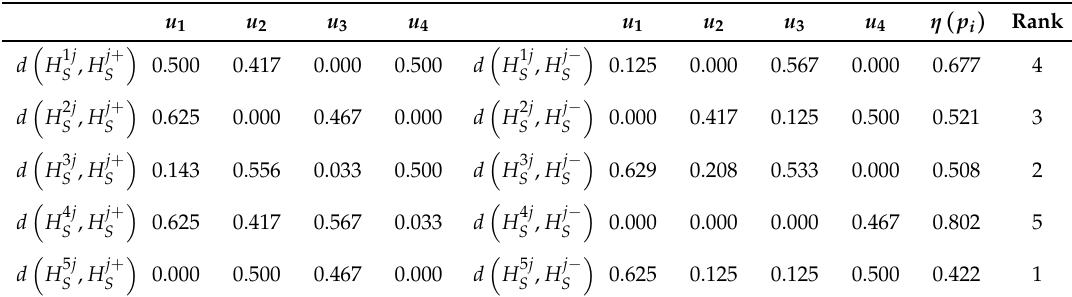
Table 9. Calculation results of the illustrative example using the method of Farhadinia [67].